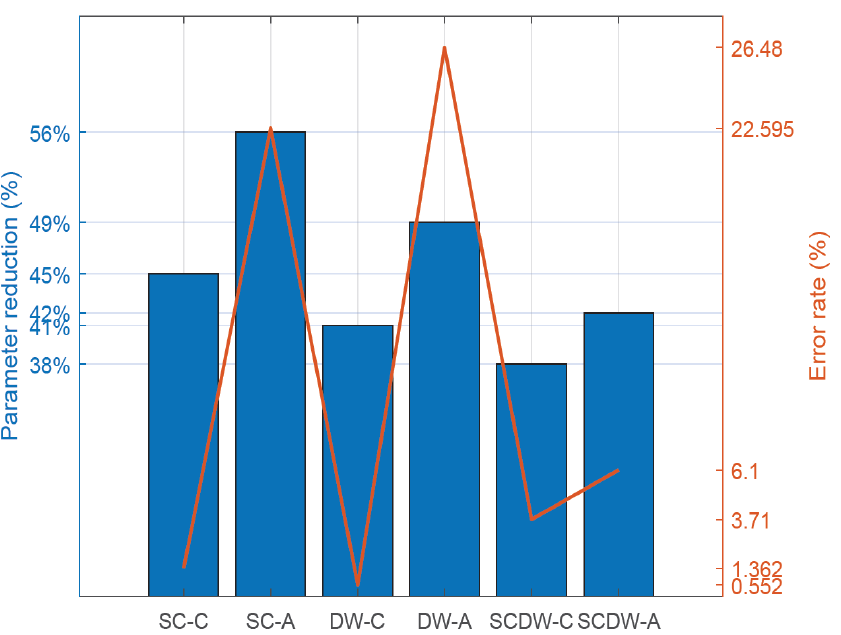
Figure 5. Comparison between network error rate and model parameter reduction under different pruning